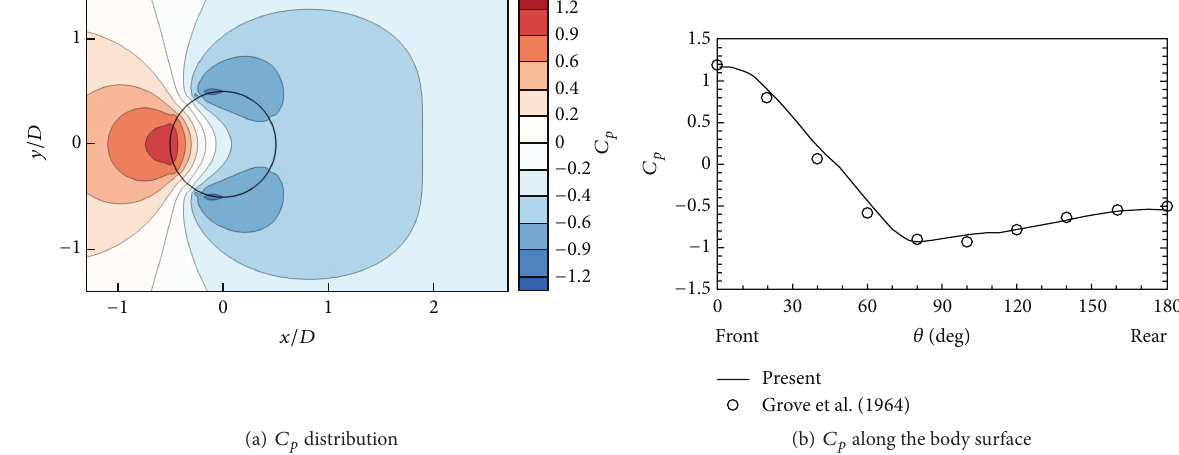
Figure 2: Pressure contours (right) and pressure coefficients at the body surface (left) for steady flow past a circular cylinder at Re = 40 .